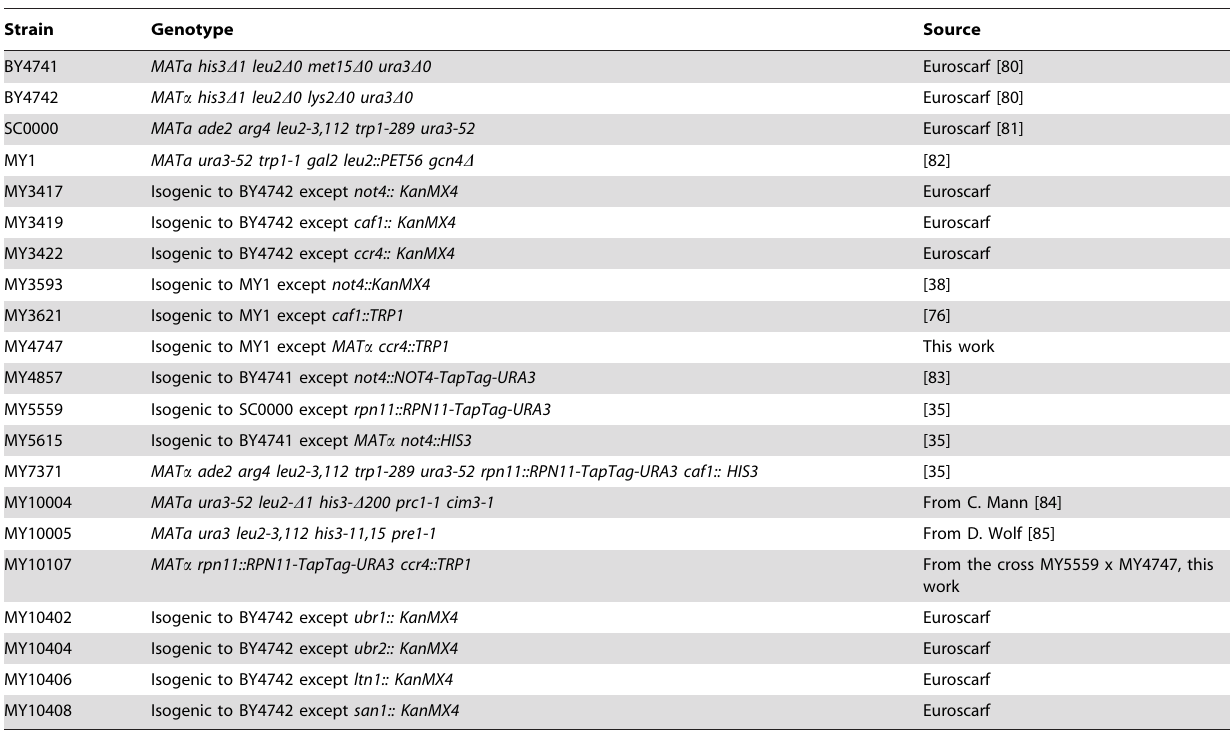
Table 1. Yeast strains used in this study.